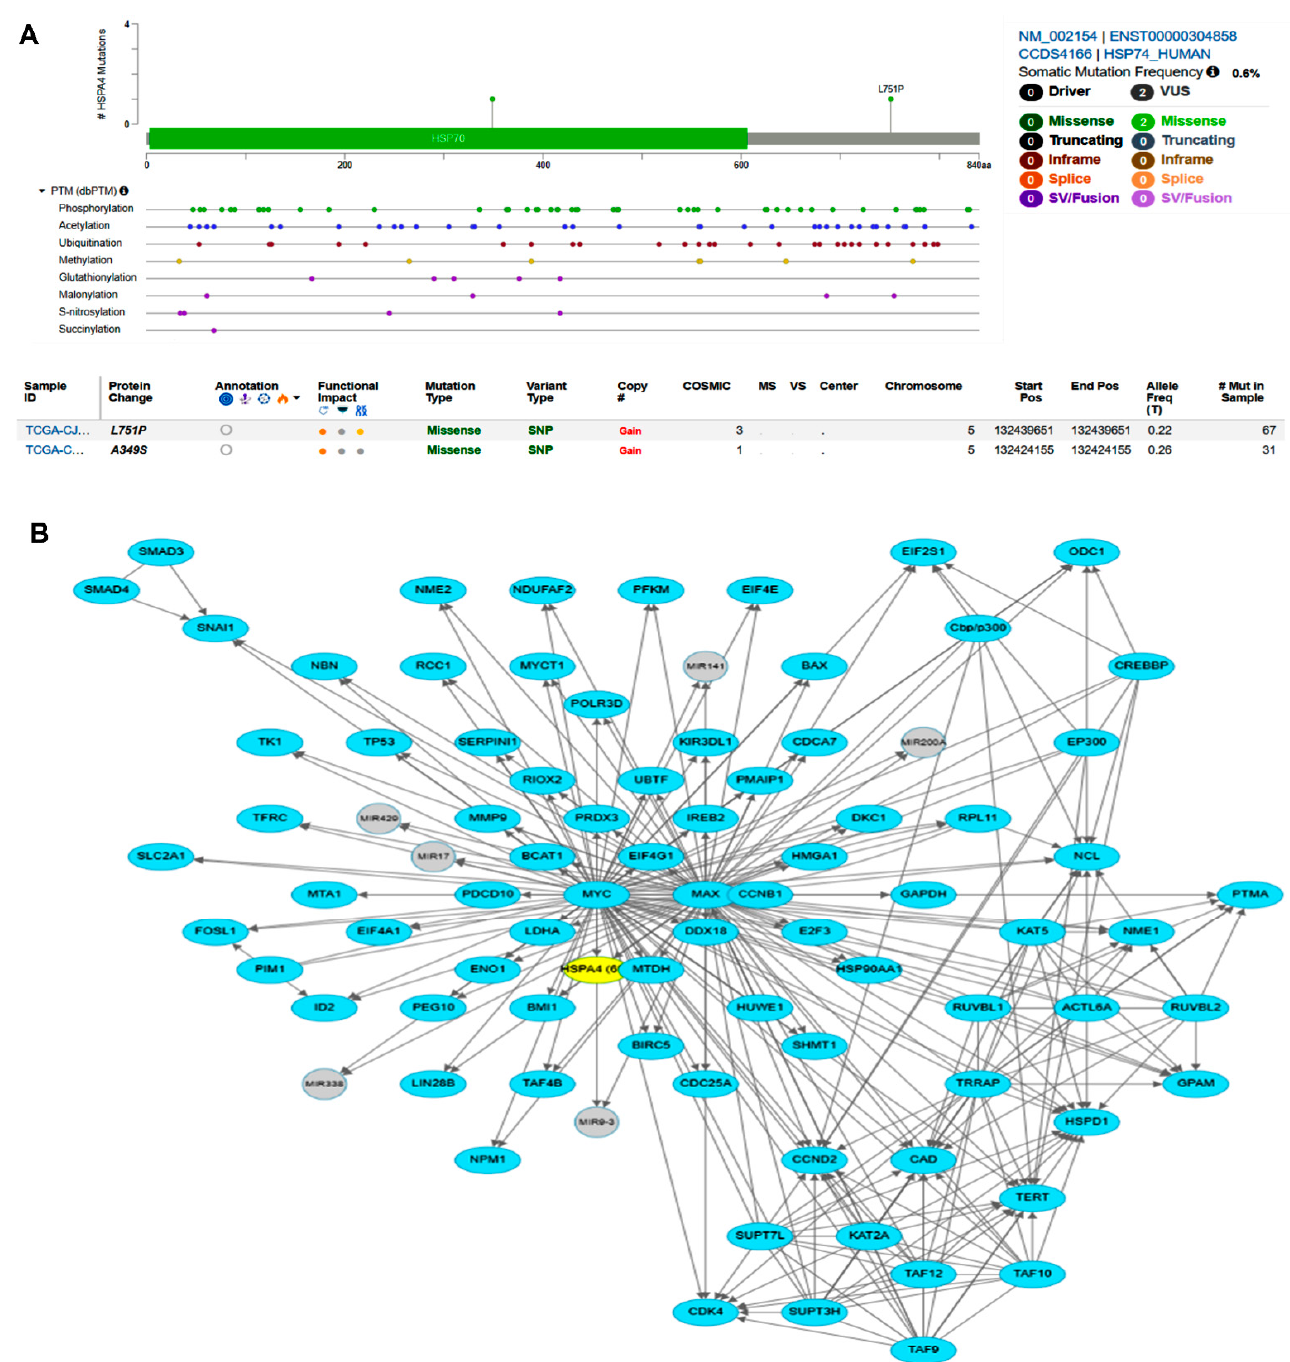
Figure 9. cBioPortal database genomic and network analysis of HSP70 in renal cell carcinoma (RCC). ( A ) Missense mutations that could impact the HSP70 expression level in RCC. ( B ) HSP70 is one of the validated targets for C-MYC transcriptional activation.